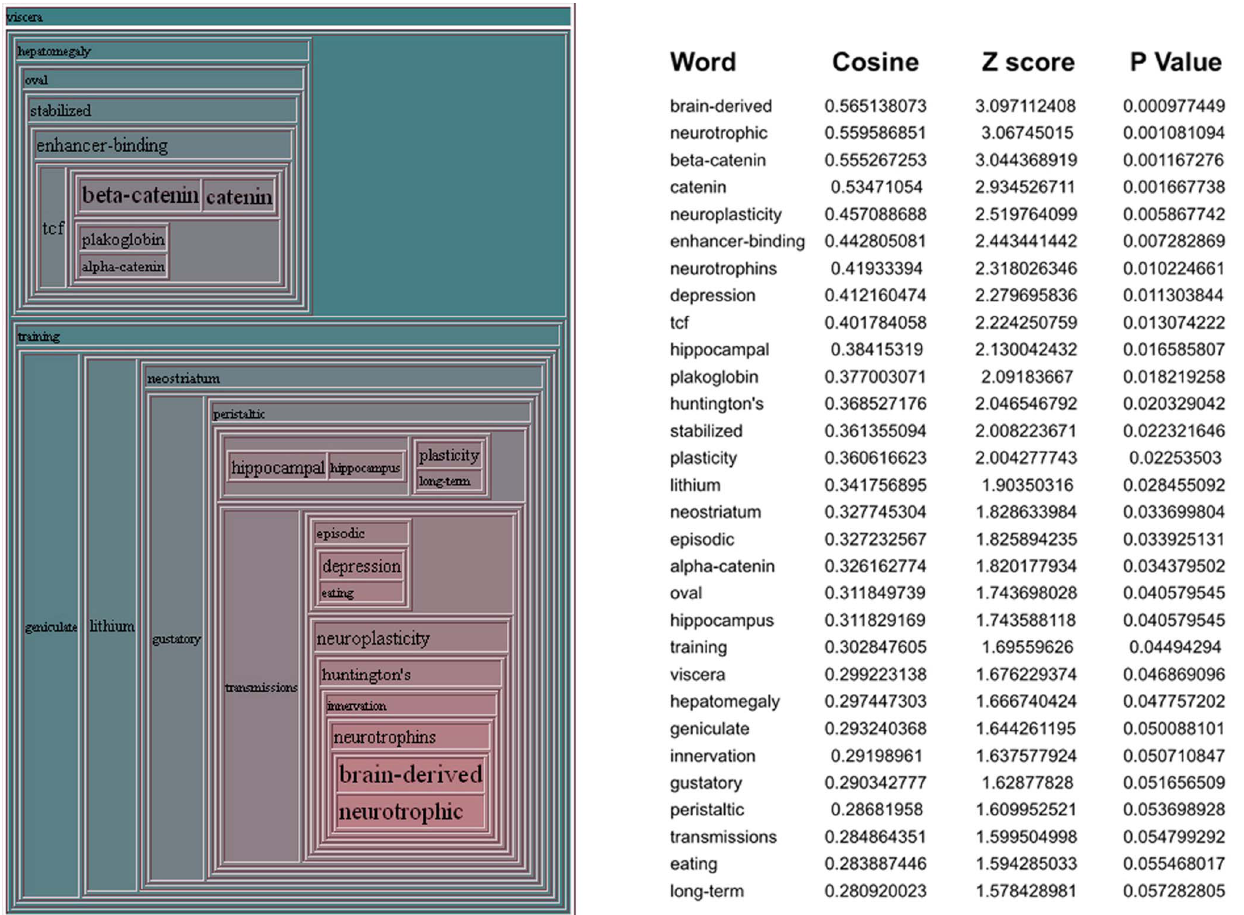
Figure 4. Hierarchical cloud collective processing from large physiological datasets. The hierarchical cloud represents the most strongly associated words with a large input dataset derived from behavioral experiments investigating learning task-oriented activity in mice. The highest scoring (Cosine Similarity, Z score, probability) words extracted by Textrous! for the input dataset are indicated next to the hierarchical cloud.